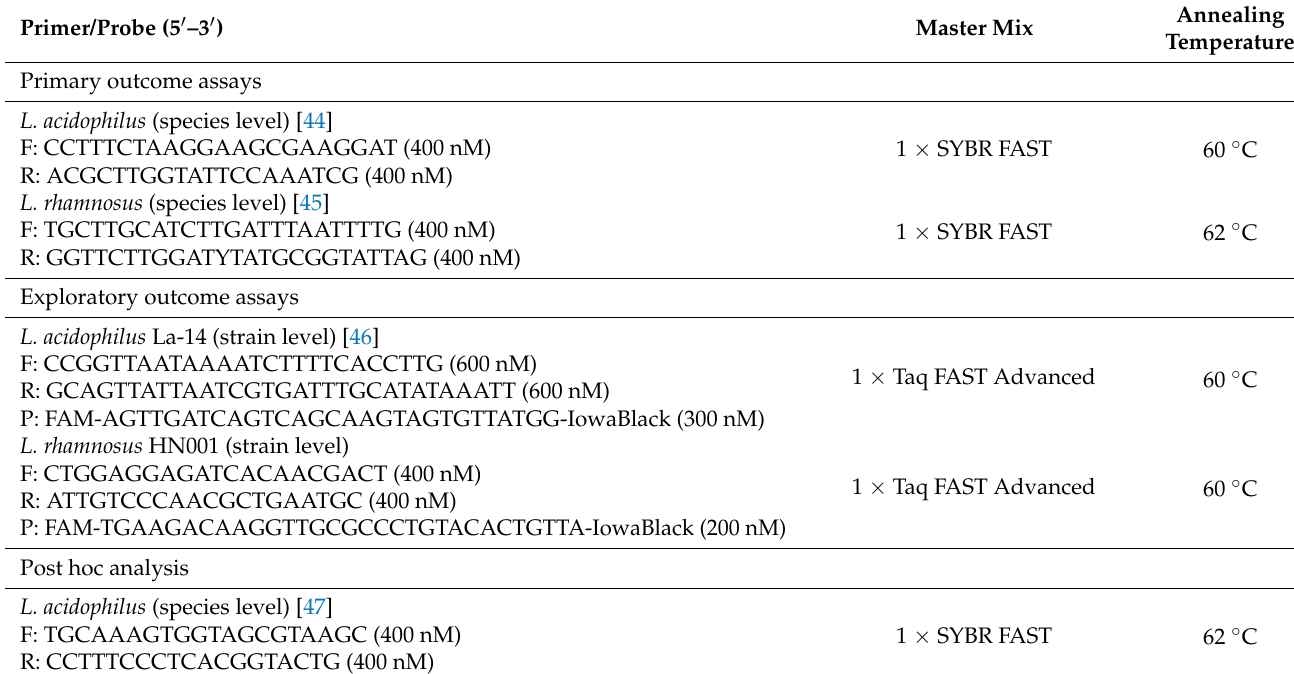
Table 2. Quantitative PCR (qPCR) assays applied to assess colonisation of supplemented strains from vaginal swab samples. F, forward primer; R, reverse primer; P,